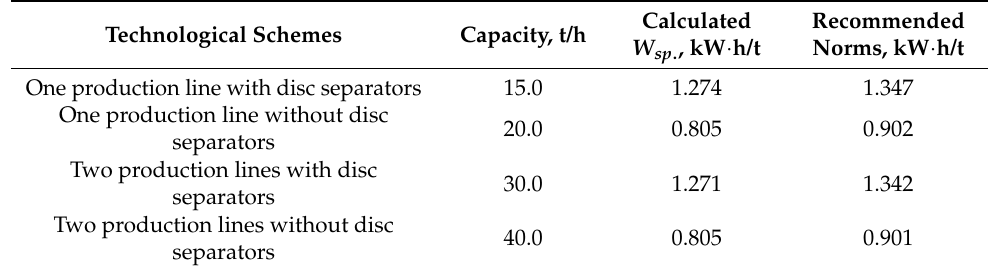
Table 2. Recommended scientifically based norms of electricity consumption when cleaning grain on the production lines of the ZAV-40 grain cleaning